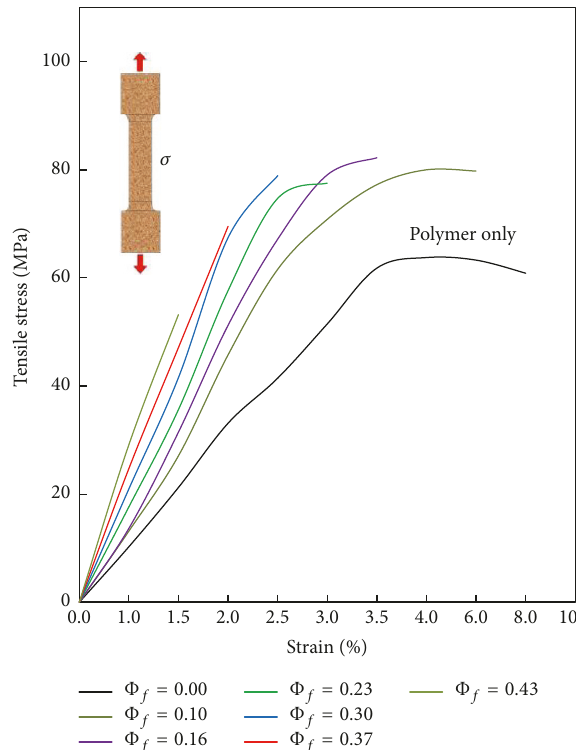
Figure 7: The copper filler particle size effect on thermal conduc- tivity.